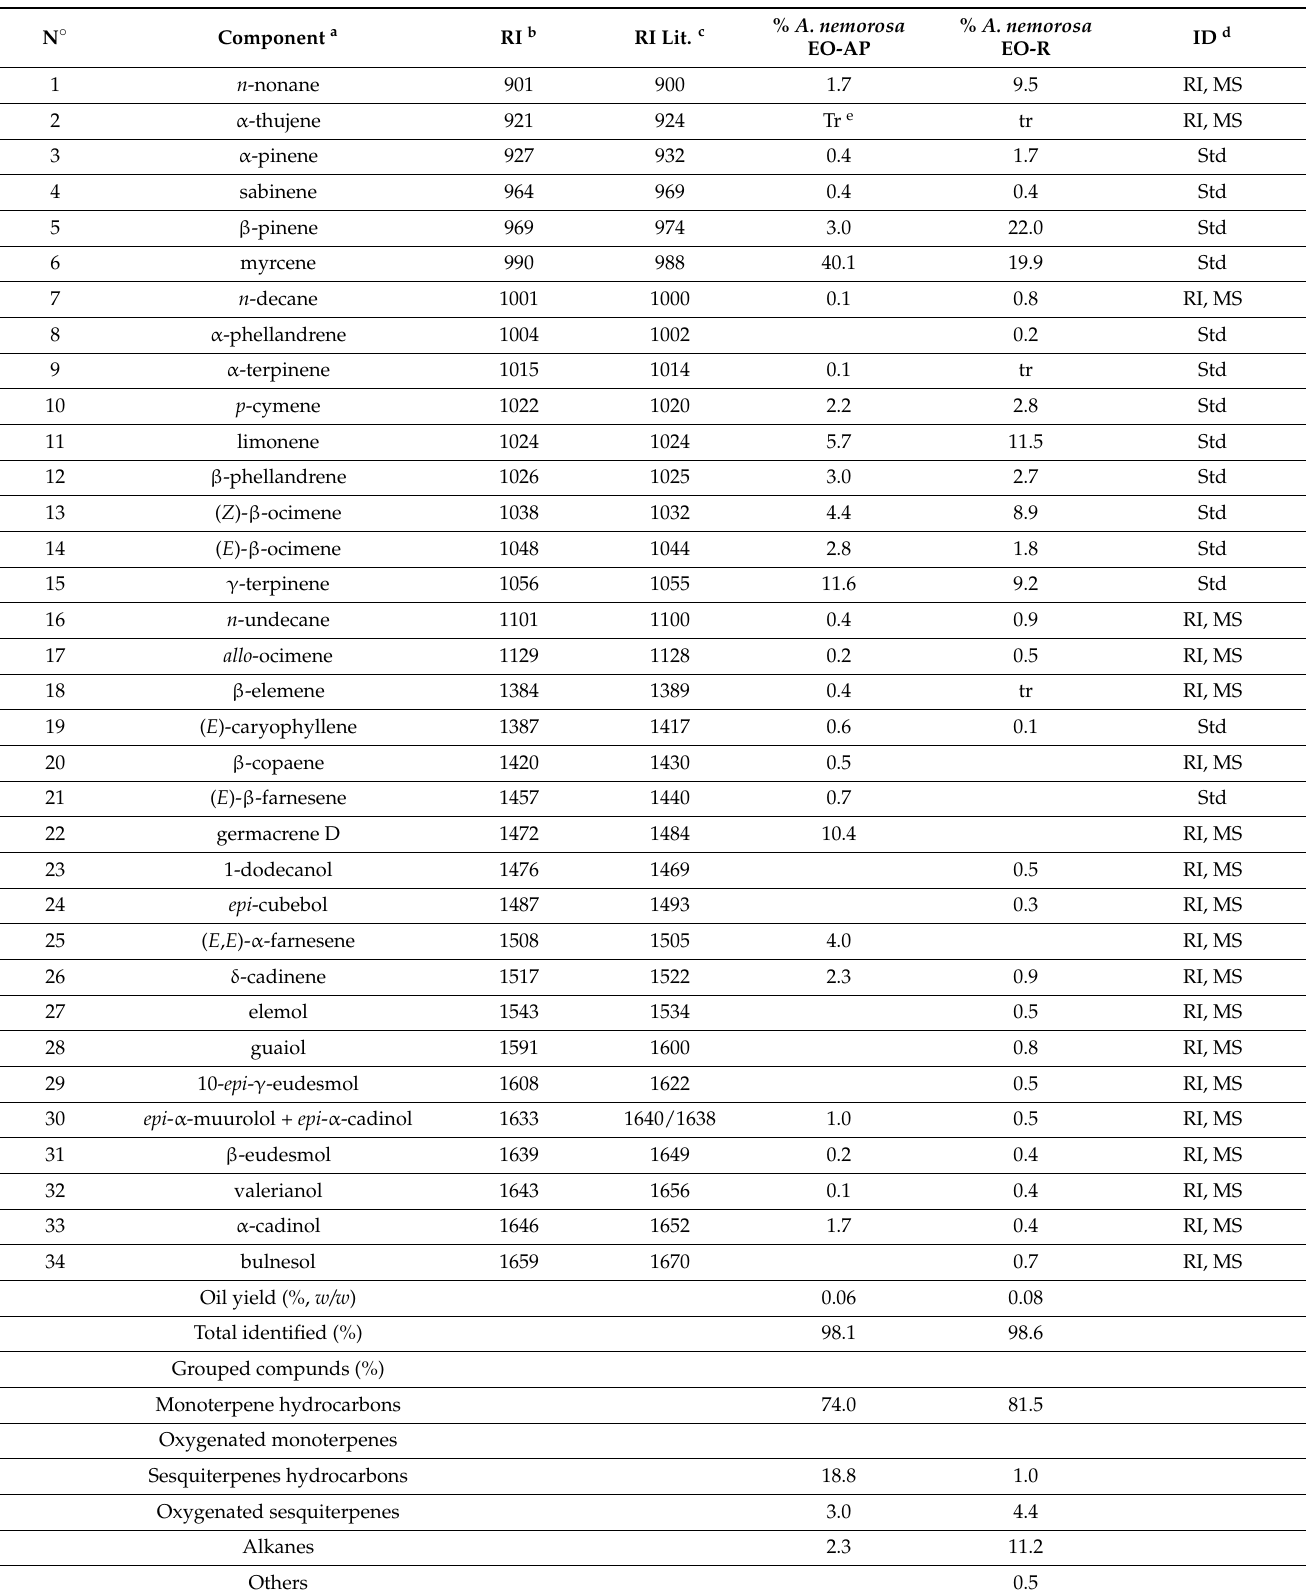
Table 1. Chemical composition of the EOs obtained from A. nemorosa aerial parts and